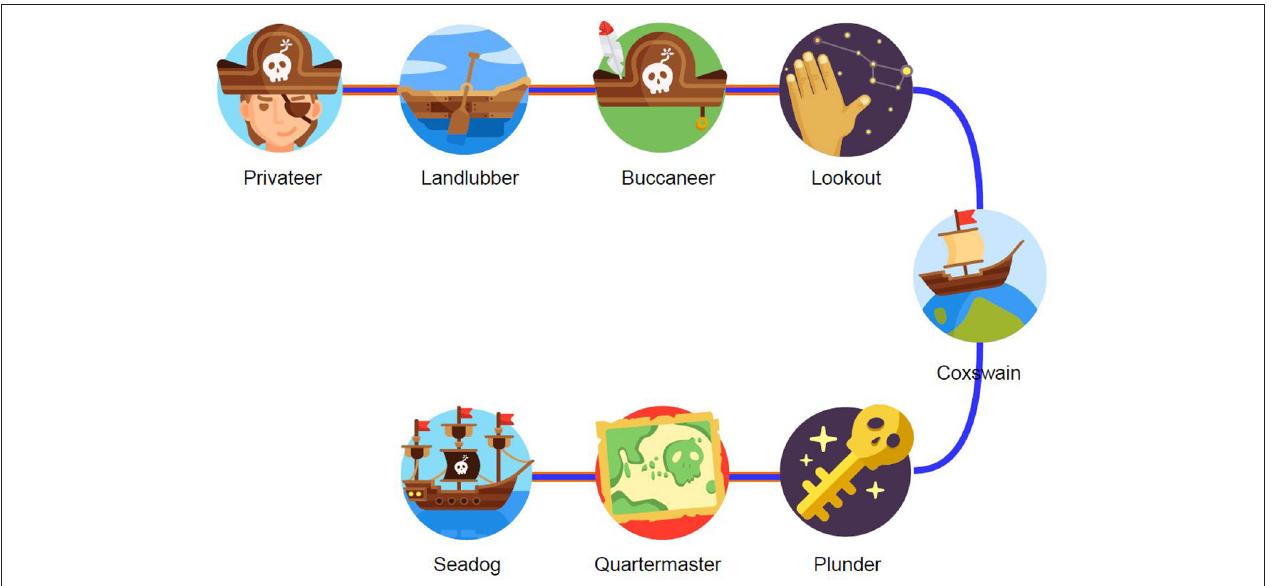
FIGURE 2 | Badges can be used to illustrate progression, besides individual